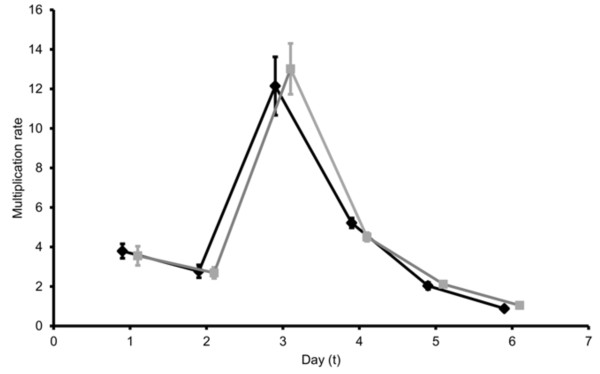
Multiplication rate (number of progeny produced per parasite). The means (±se) for matched (black lines) and mismatched (grey lines) infections are plotted for each cycle of replication (data plotted on the x-axis are offset for clarity), calculated as the number of parasites observed on day t + 1 divided by the number on the previous day (t). For example, data plotted on day 1 represent the multiplier between day 1 to day 2.